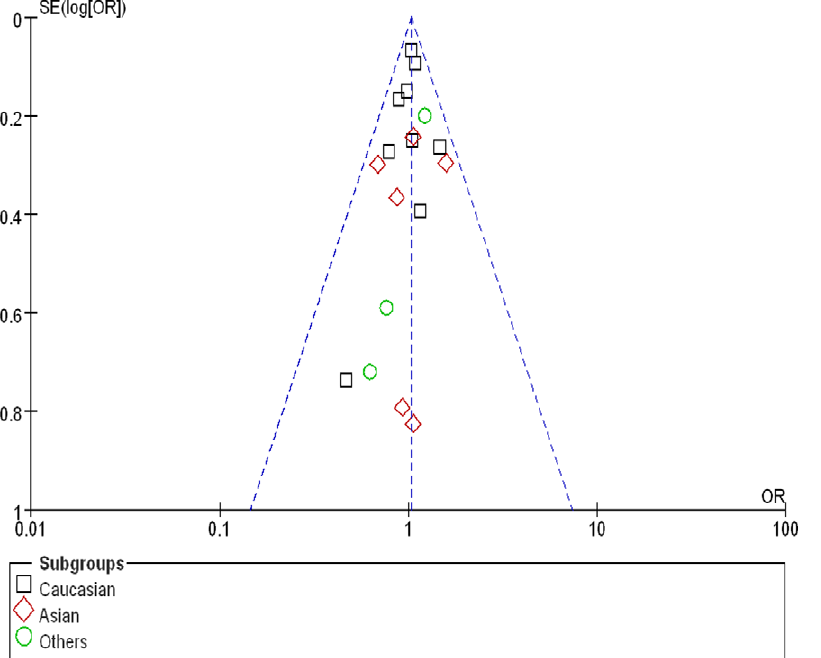
Figure 2. Funnel plots analysis to detect publication bias. Each point represents an independent study for the indicated association. doi:10.1371/journal.pone.0018480.g002 PLoS ONE |